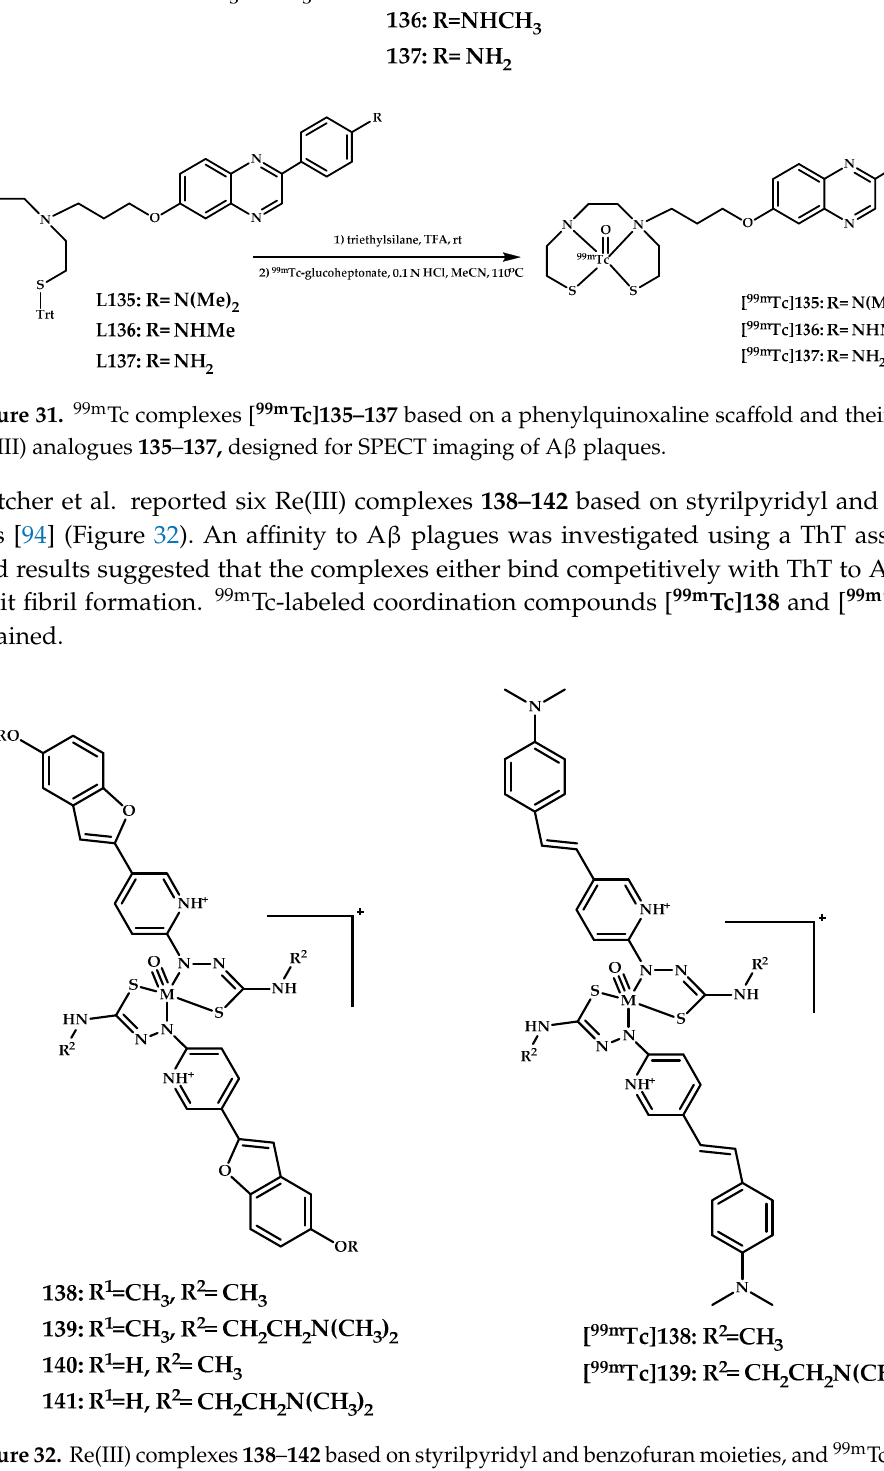
Figure 32. Re(III) complexes 138–142 based on styrilpyridyl and benzofuran moieties, and 99m Tc labeled coordination compounds [ 99m Tc] 138 and [ 99m Tc] 139, designed for SPECT imaging of A β